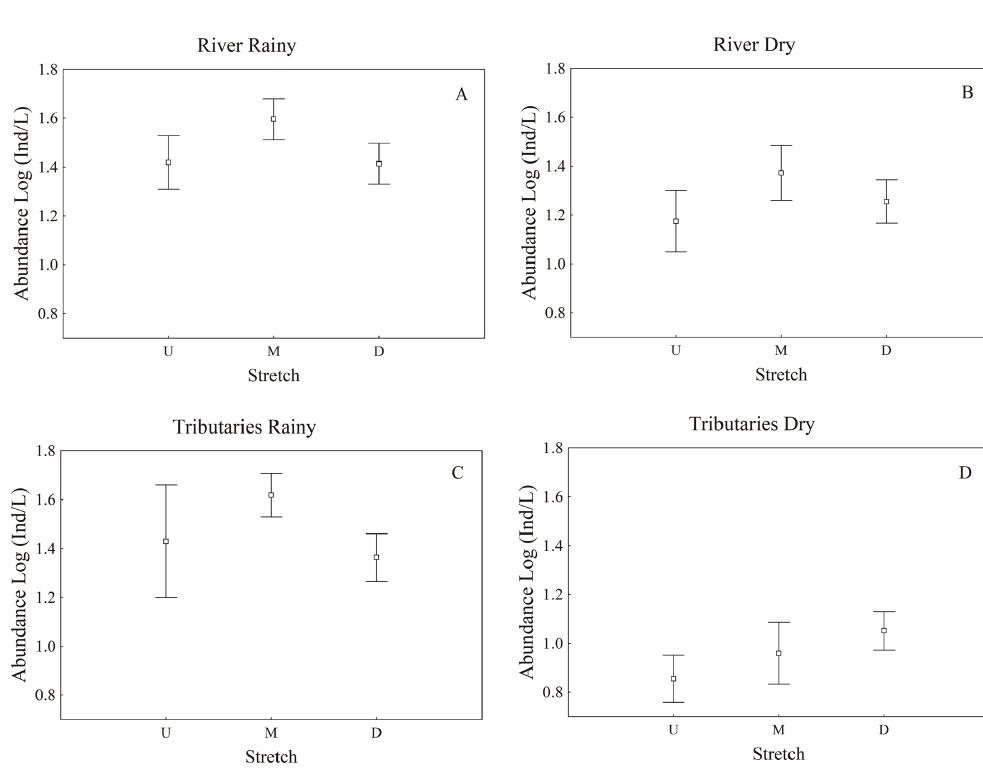
Figure 2. Ciliate abundances registered in the Paraná River during the rainy (A) and dry (B) periods and its tributaries during the rainy (C) and dry (D) periods in each stretch – upstream (U), middle (M), and downstream (D).